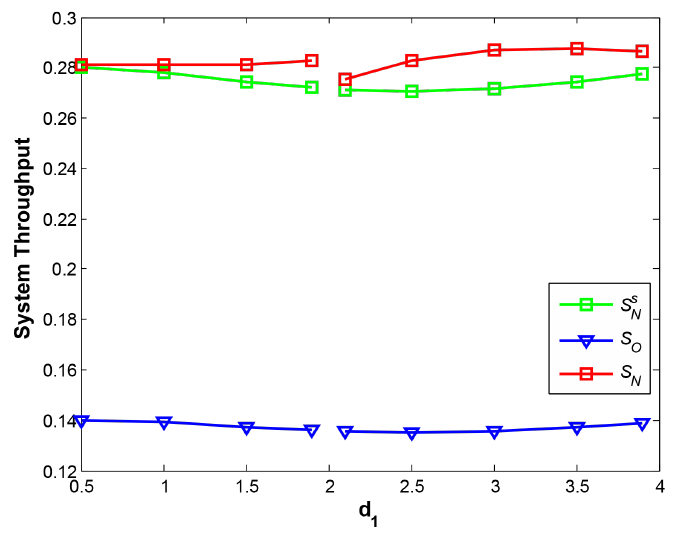
Figure 10. System throughput vs. d 1 .